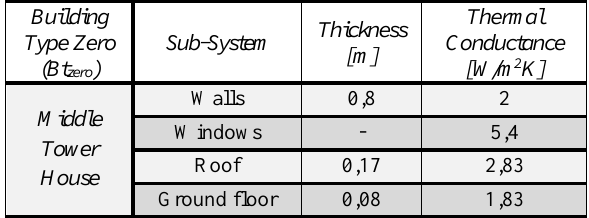
Table 1. Thermal performances of the envelope in the Building